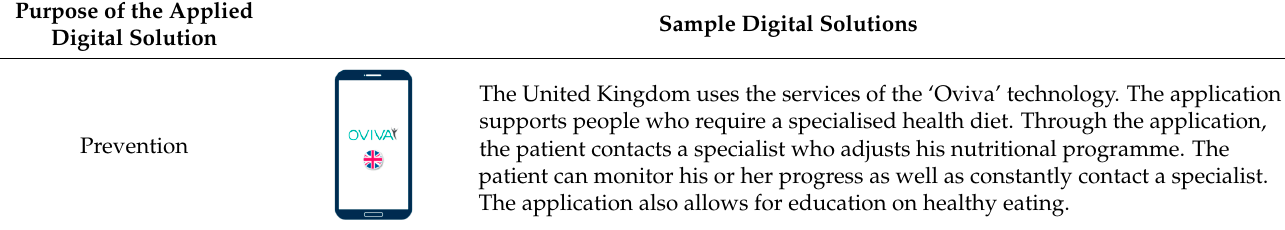
Table 2. Review of sample digital solutions [44].